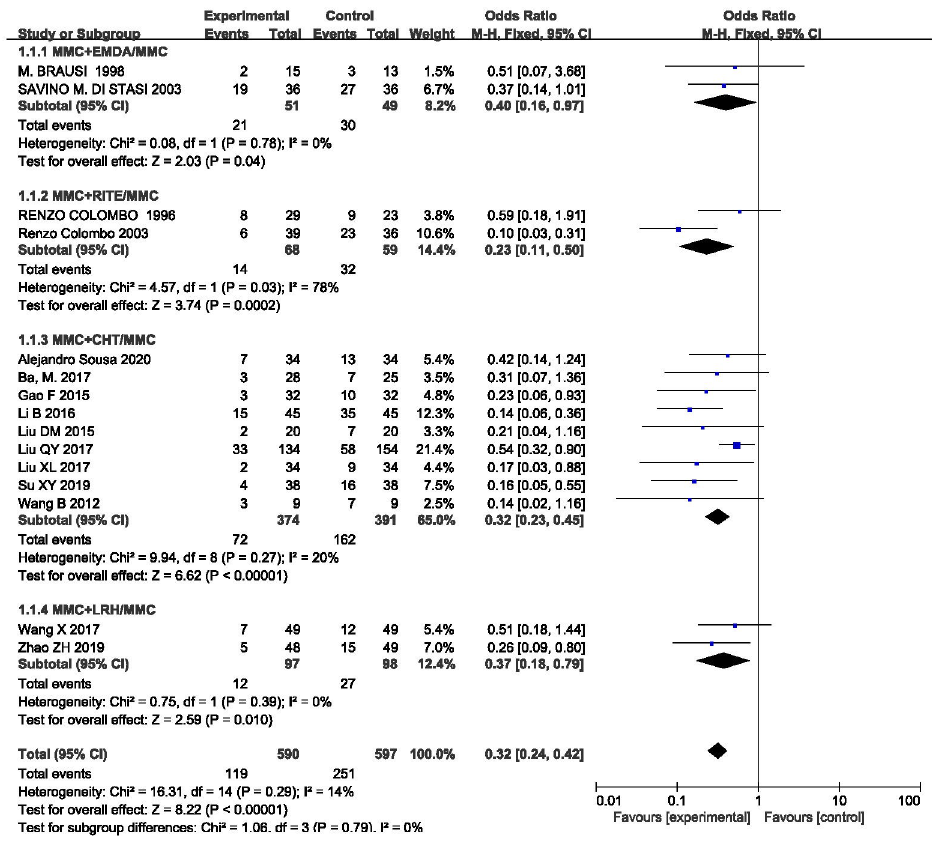
Fig 4. Forest plots for the meta-analysis of the recurrence rates by the different